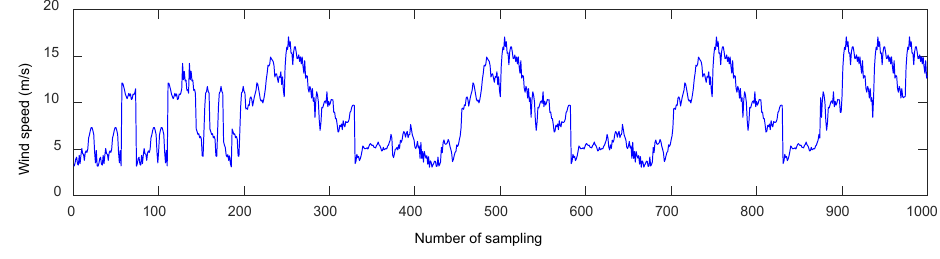
Figure 2. Field-measured wind speed data.